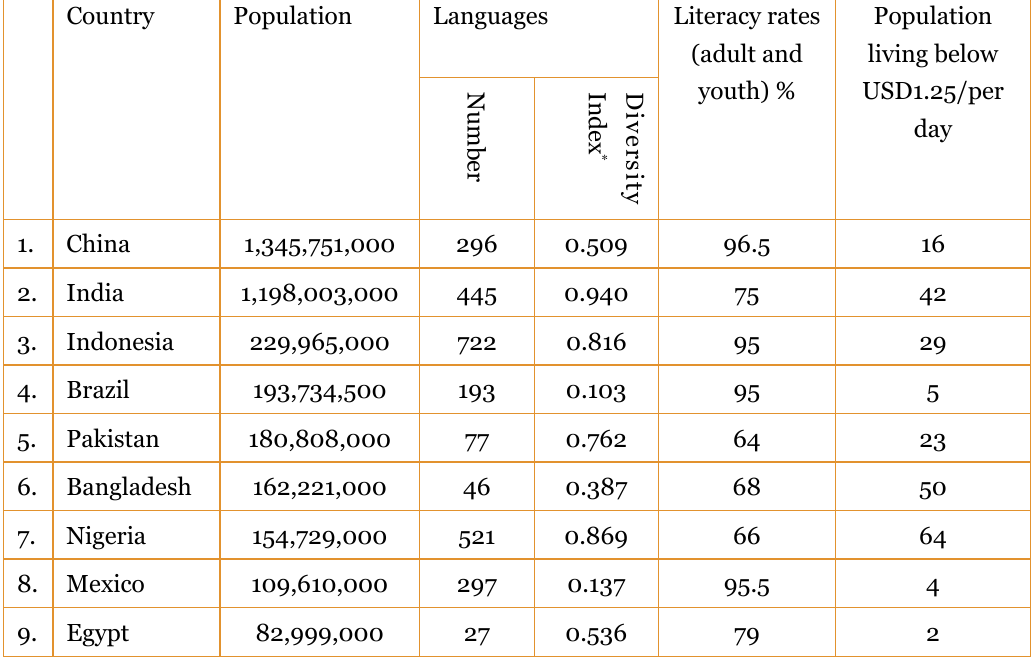
(adult and youth) %